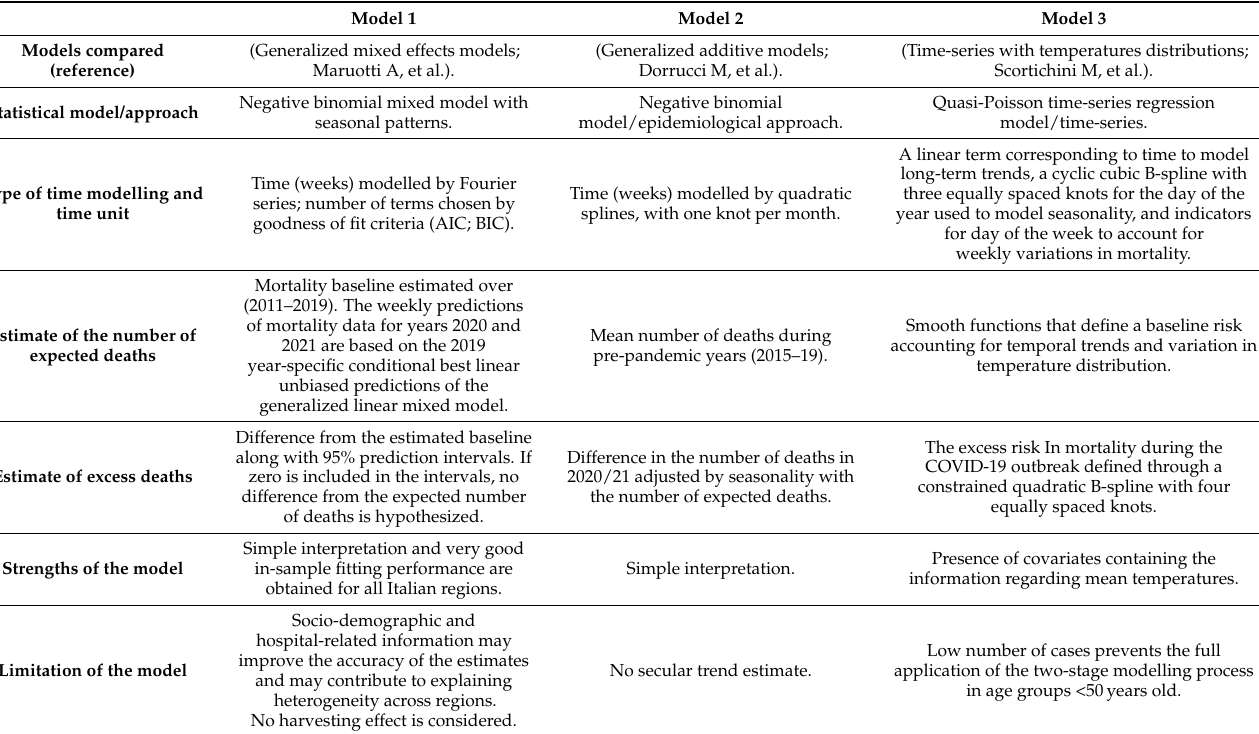
Table 1. Main characteristics of the three models chosen to compare excess mortality estimates